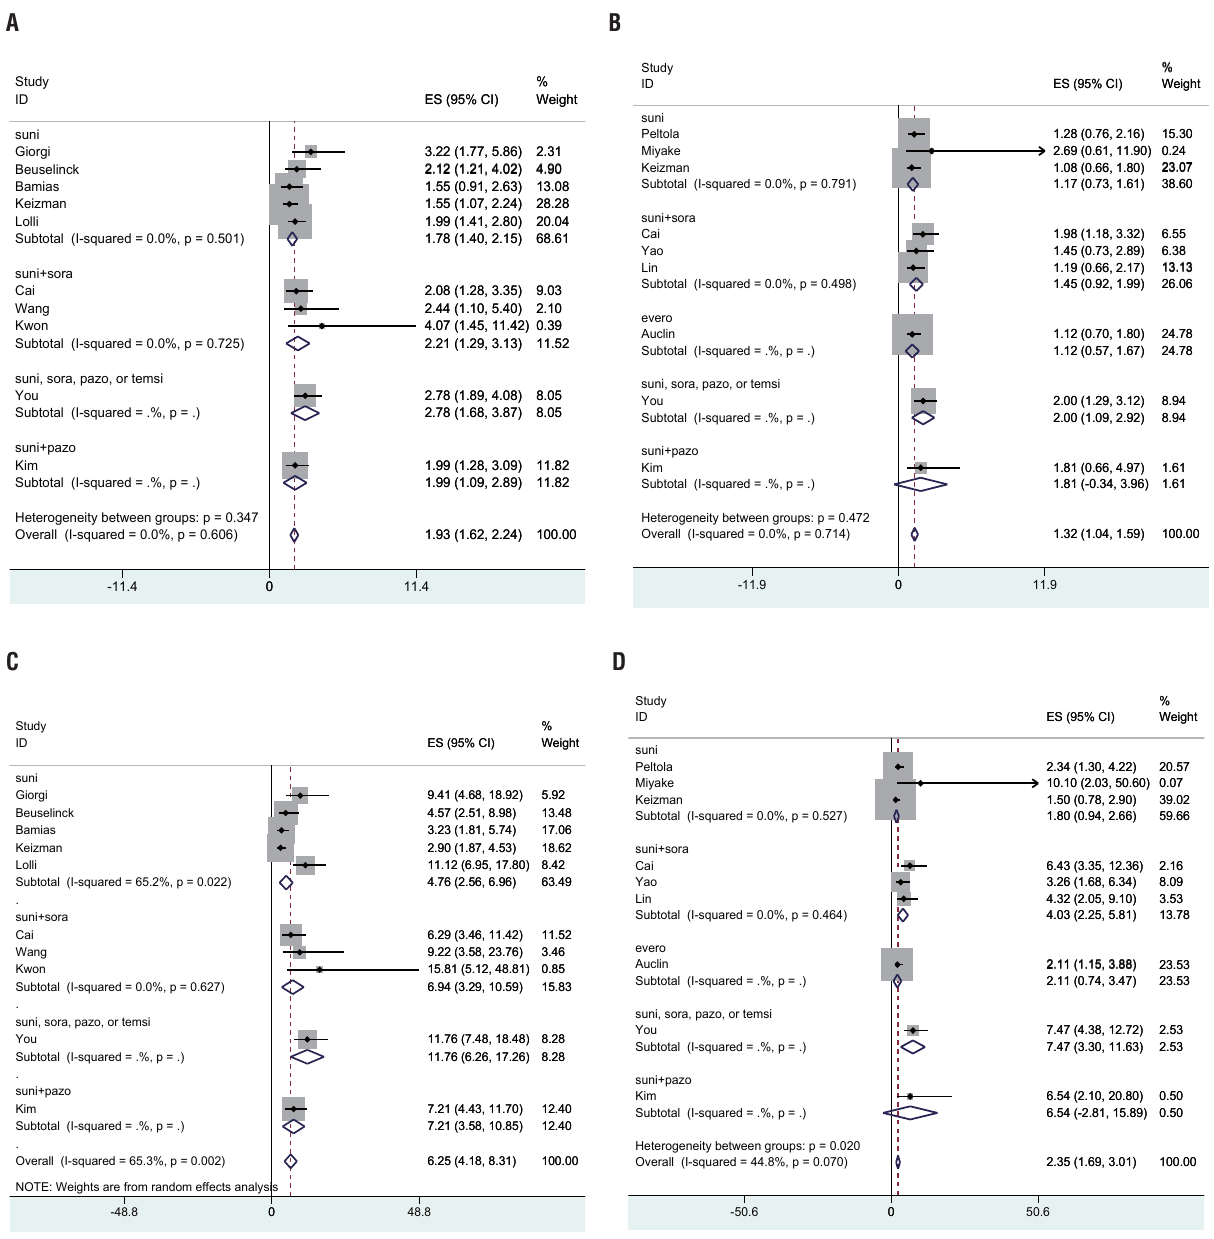
a) OS univariate analysis of intermediate to favorable risk group for area; b) OS univariate analysis of poor to favorable risk group for area; c) OS multivariate analysis of intermediate to favorable risk group for area; d) OS multivariate analysis of poor to favorable risk group for area.